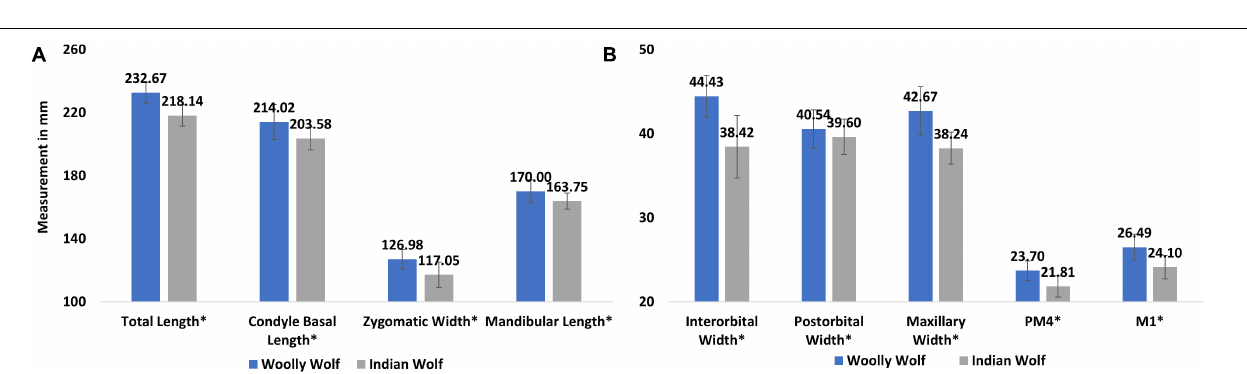
FIGURE 5 | Comparison of the relative frequency of occurrence of different food types of Woolly and Indian wolf; based on (A) prey size (0–10 kg small prey; 11–70 kg medium-sized prey; > 70 kg large prey) and (B) prey types in the diet.